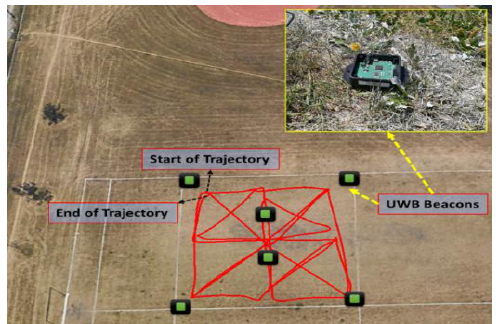
Figure 3. The trajectory of the real flight experiment, and UWB anchors distributed around the area of interest Sample of the estimated position from the UWB system with 33% less in the infrastructure (4 anchors) compared to the positions estimated from the full UWB system is shown in